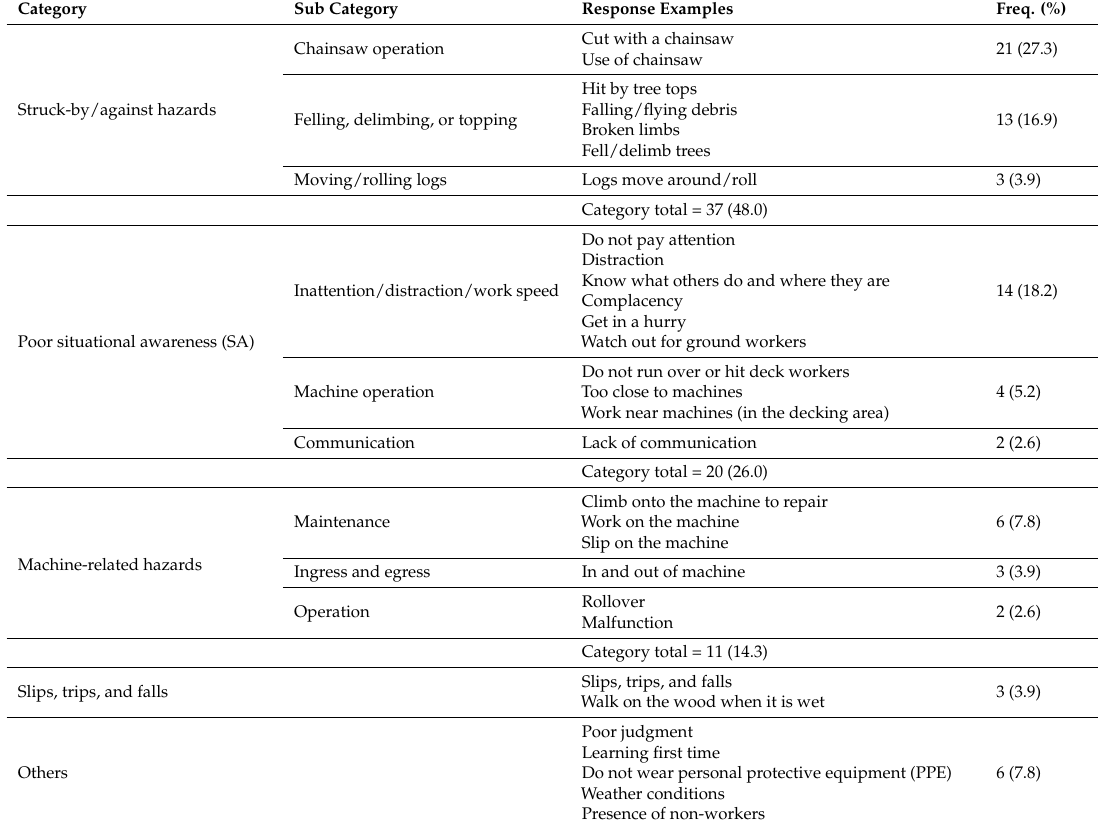
Table 3. Summary of responses ( total = 77 responses, from 77 individuals who responded to this open-end question) regarding the biggest safety risks perceived during logging operations. Note that n in the table is the number of responses obtained.